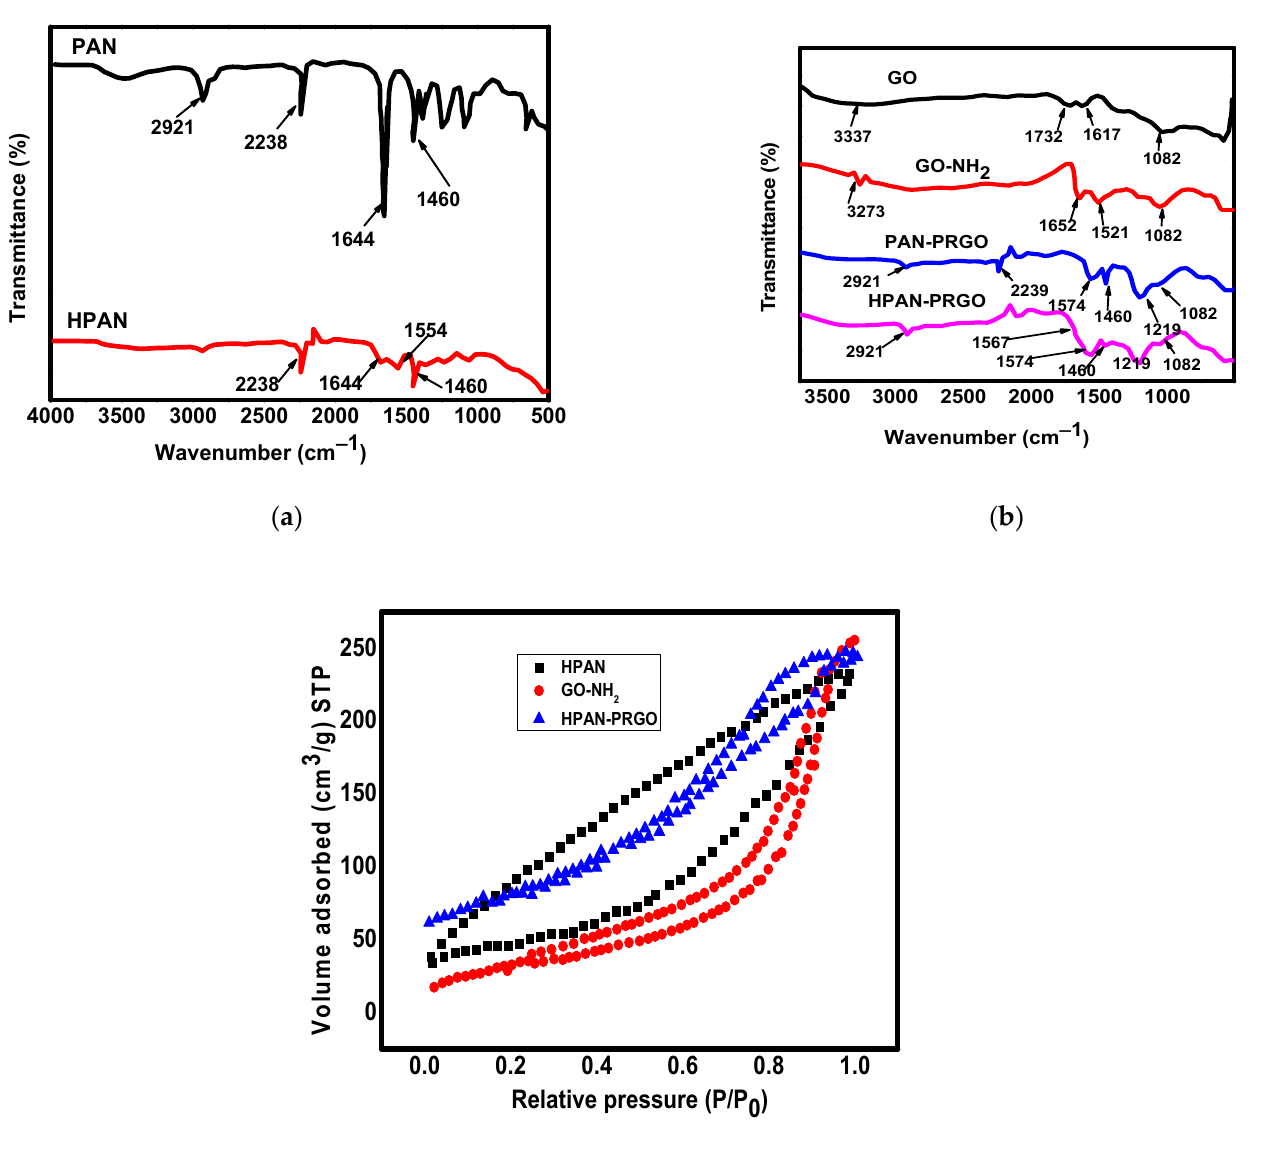
Figure 4. FT-IR of synthesized materials. ( a ) PAN and HPAN, ( b ) HPAN-PRGO, PAN-PRGO, GO-NH 2 , and GO, and ( c ) N 2 adsorption–desorption isotherm.